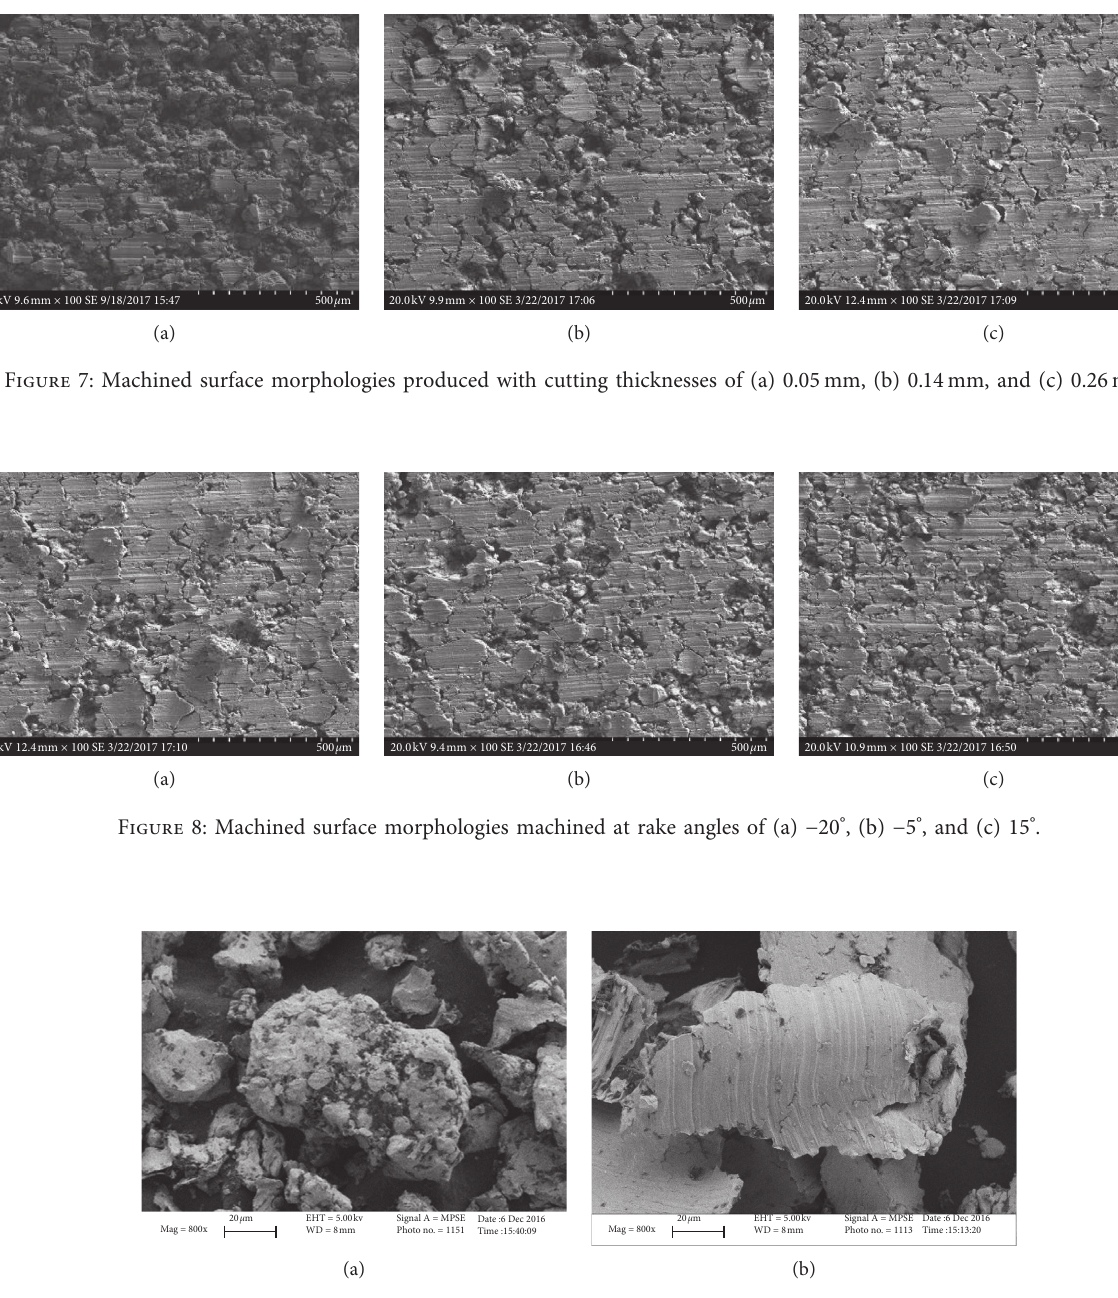
Figure 9: Chip morphologies formed by means of (a) particle peeling off and (b) shear deformation.